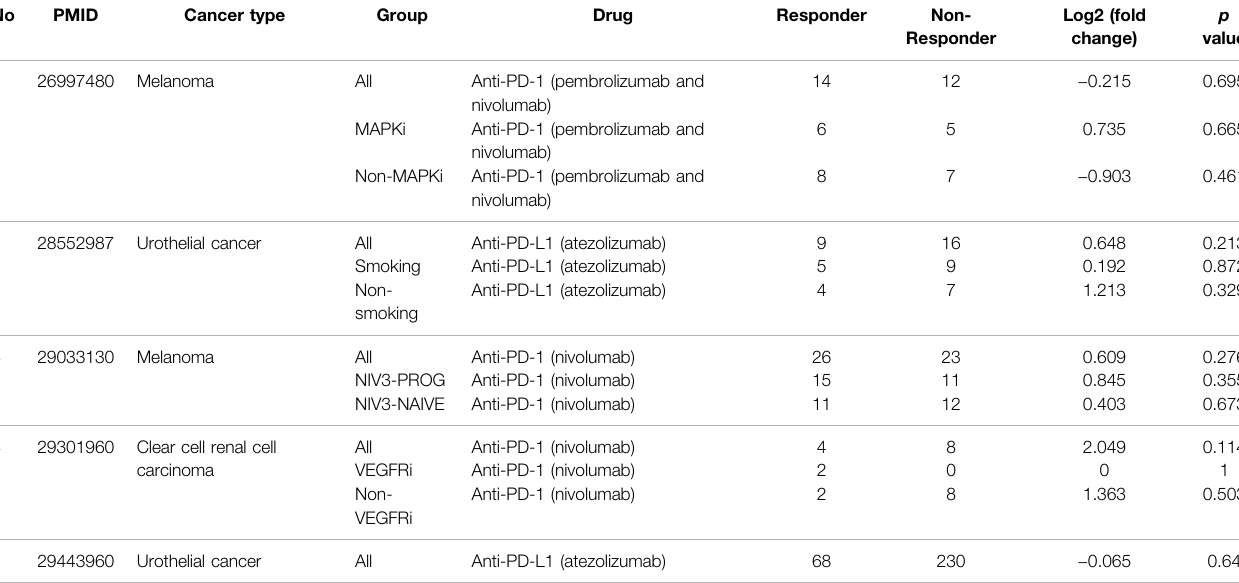
TABLE 2 | BATF expression difference between responders and non 32 responders in various data sets. No